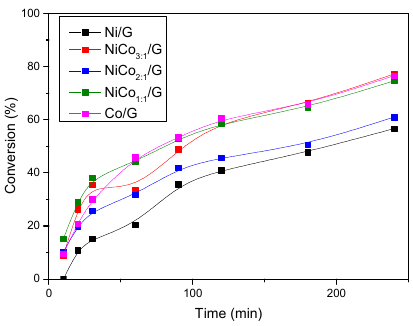
Figure 9. Evolution of guaiacol conversion with time for each catalyst at 300 °C, 50 bar.